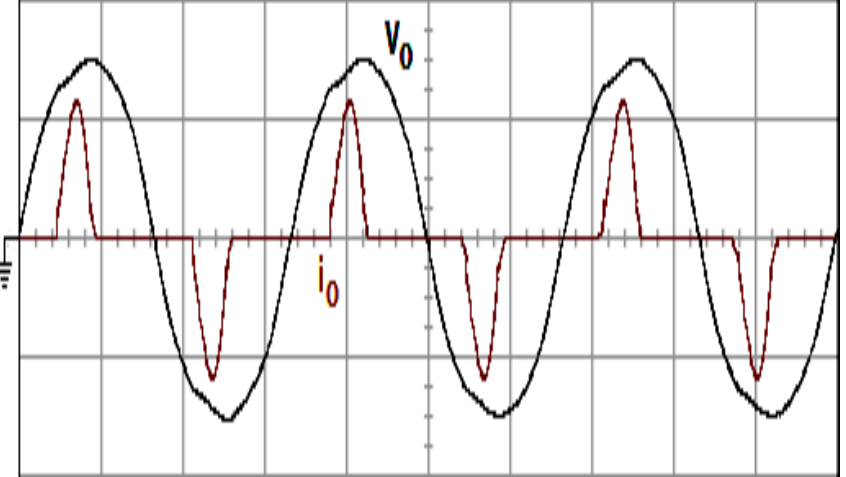
Figure 13. Experimental waveform under a rectifier load for the modified control technology (100 V/div; 25 A/div; 5 ms/div).